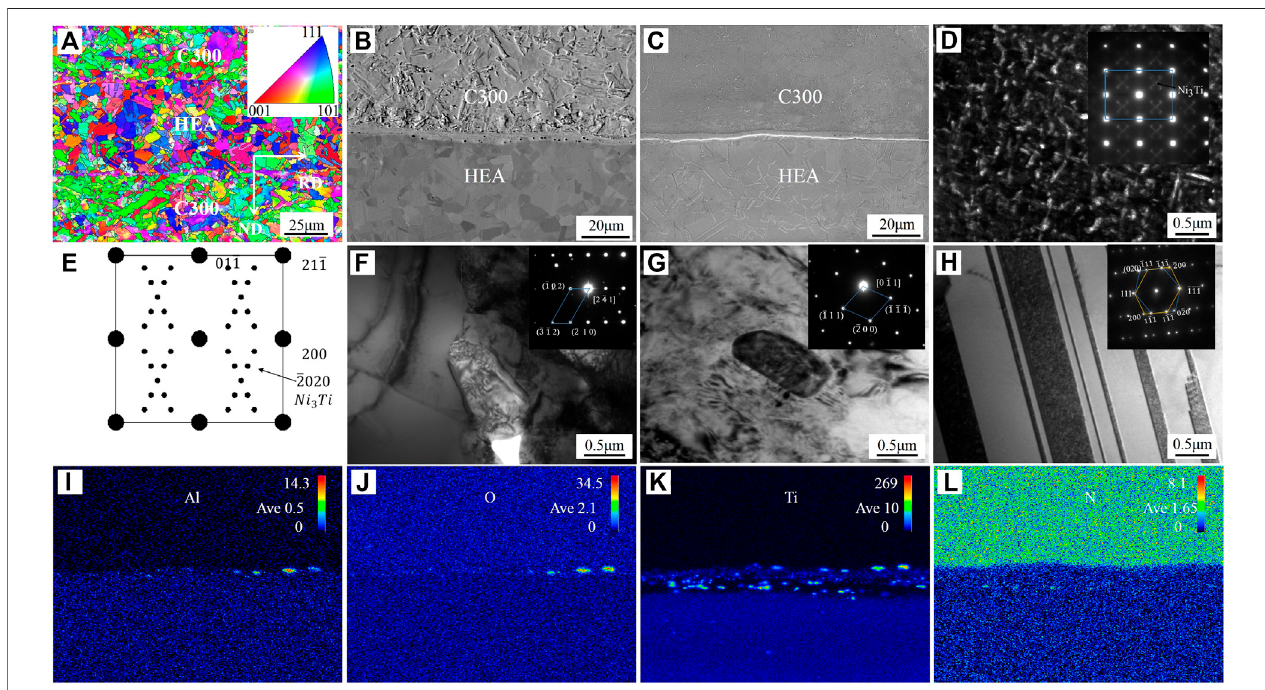
FIGURE2|(A) Electronback-scatteringdiffractionmapsoftherolledmultilayermaraging/CoCrNicomposites.RDindicatestherollingdirectionandNDthenormal direction. (B) Scanning electron microscopy (SEM) of hot-rolled sample. (C) SEM of an aged sample. (D) (F) (G) (H) Transmission electron microscopy of Ni 3 Ti, Al 2 O 3 , TiN and twinning ofagedmultilayermaraging/CoCrNi composite; (E) Indexing ofdiffraction pattern illustration of D ; (I – L) EPMAmappingdistributionofan agedsample.